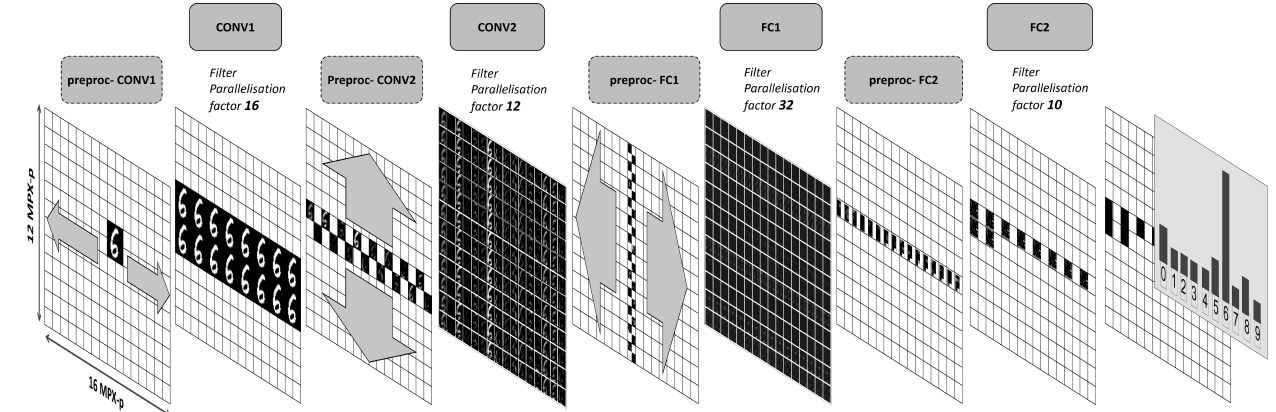
Figure 2. End-to-end pipeline implementation of the convolutional neural network model on the MPA. Each intermediate state of the data from input digit to output class distribution prediction is represented on the 16 × 12 array of MPX-p. Grey arrows indicate the flow of data over the array. The extent of filter parallelism for each layer is noted in the upper part of the